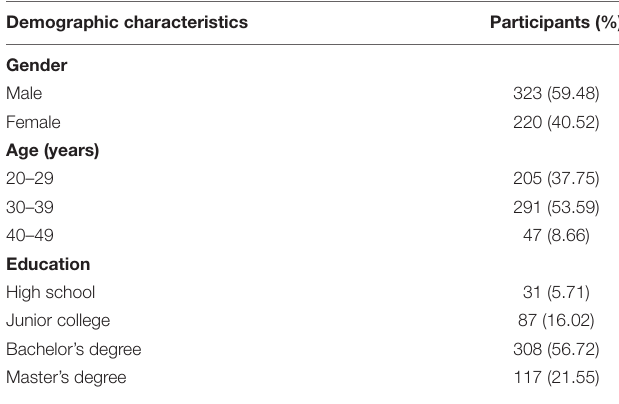
TABLE 1 | Sample demographics ( N =